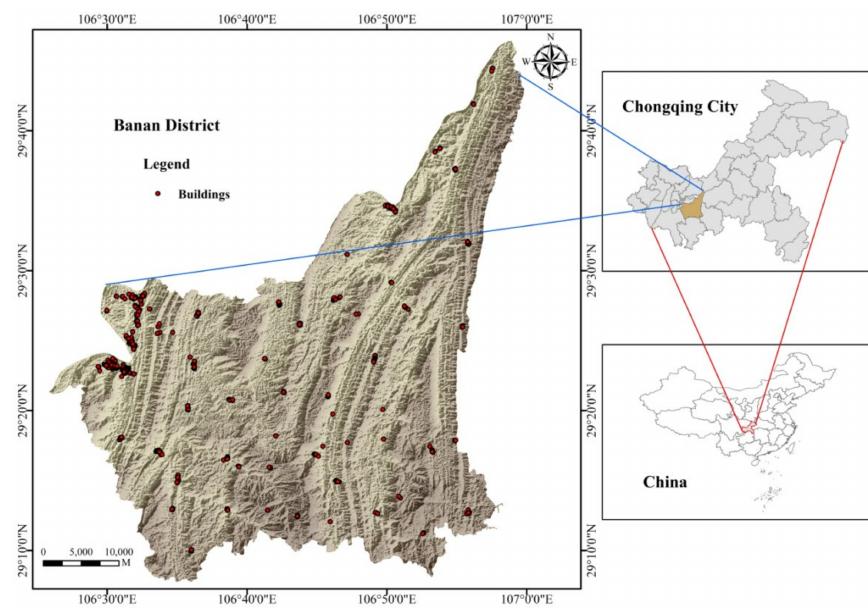
Figure 1. Location and buildings’ distribution of Banan